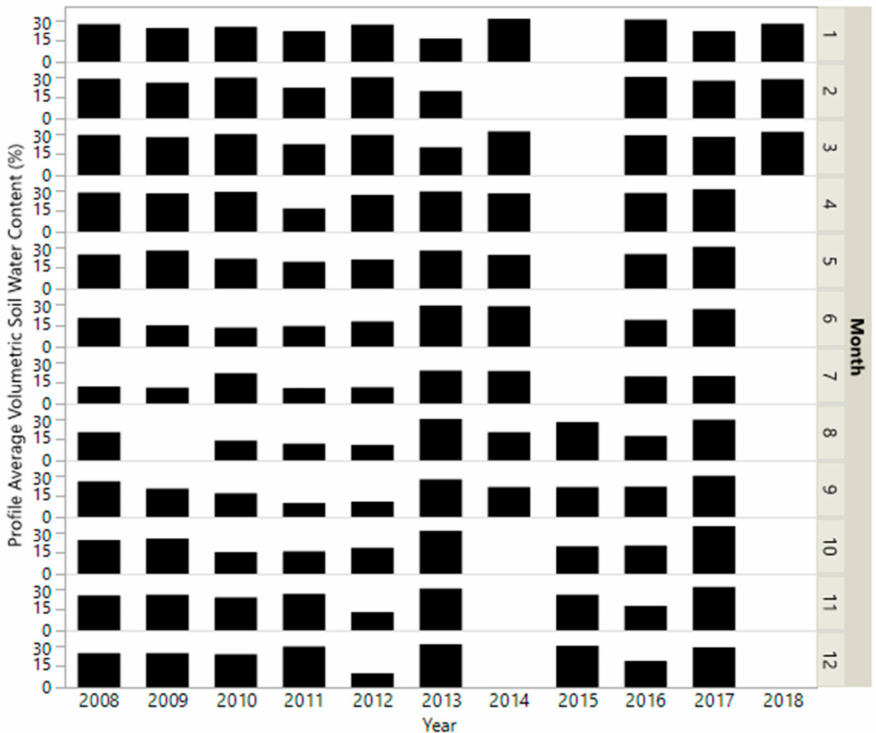
Figure A1. Monthly average volumetric water content (%) for the 0–100 cm profile by year.